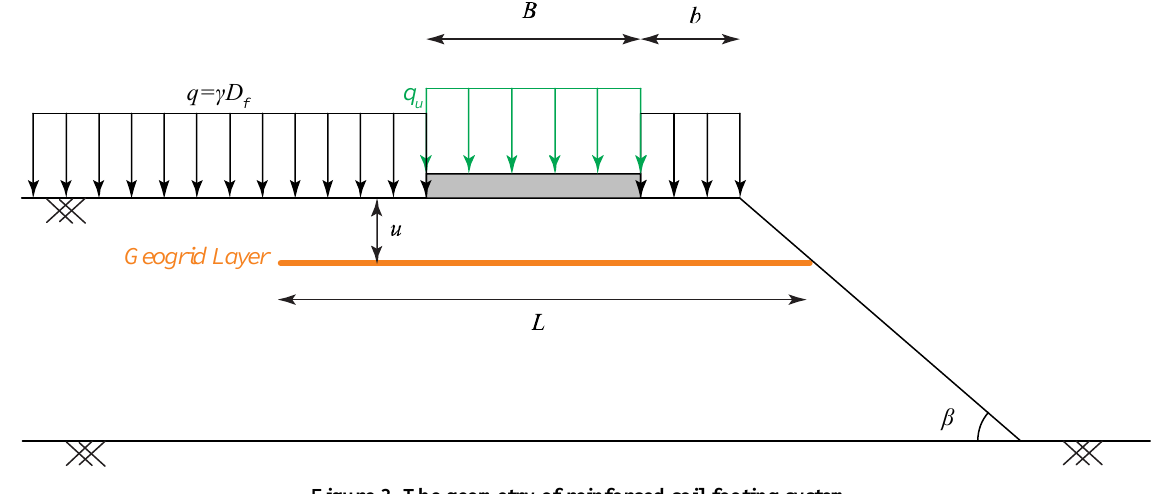
Figure 3. The geometry of reinforced soil-footing system